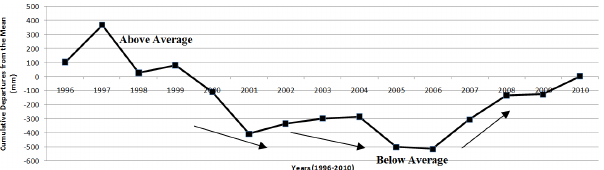
Figure 3. Cumulative departures from the mean for Subset